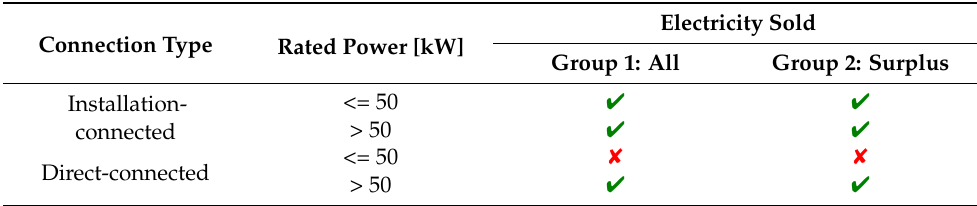
Table 1. Hourly net settlement possibilities for new PV facilities under the Danish regulatory framework.